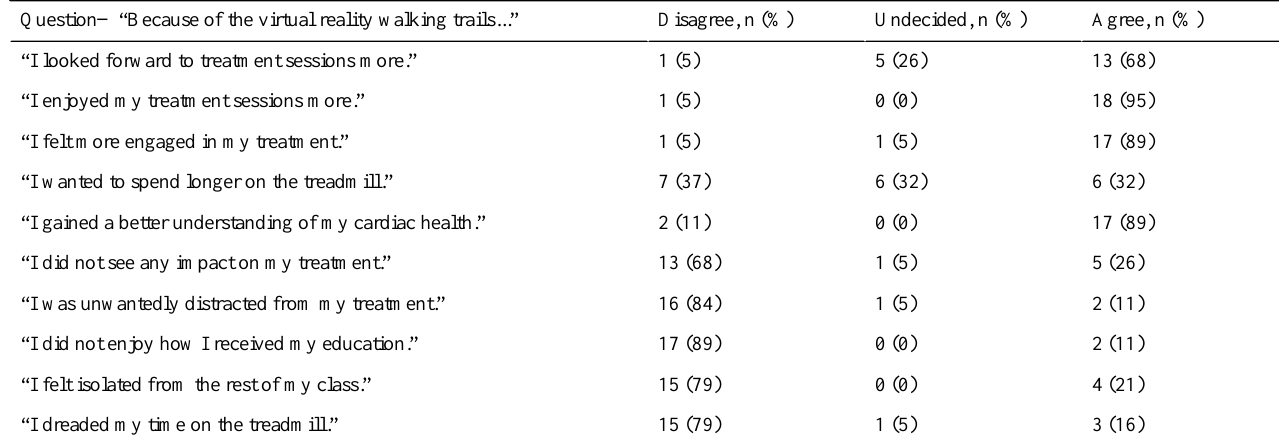
Table 4. Virtual reality–specific satisfaction (n=19).